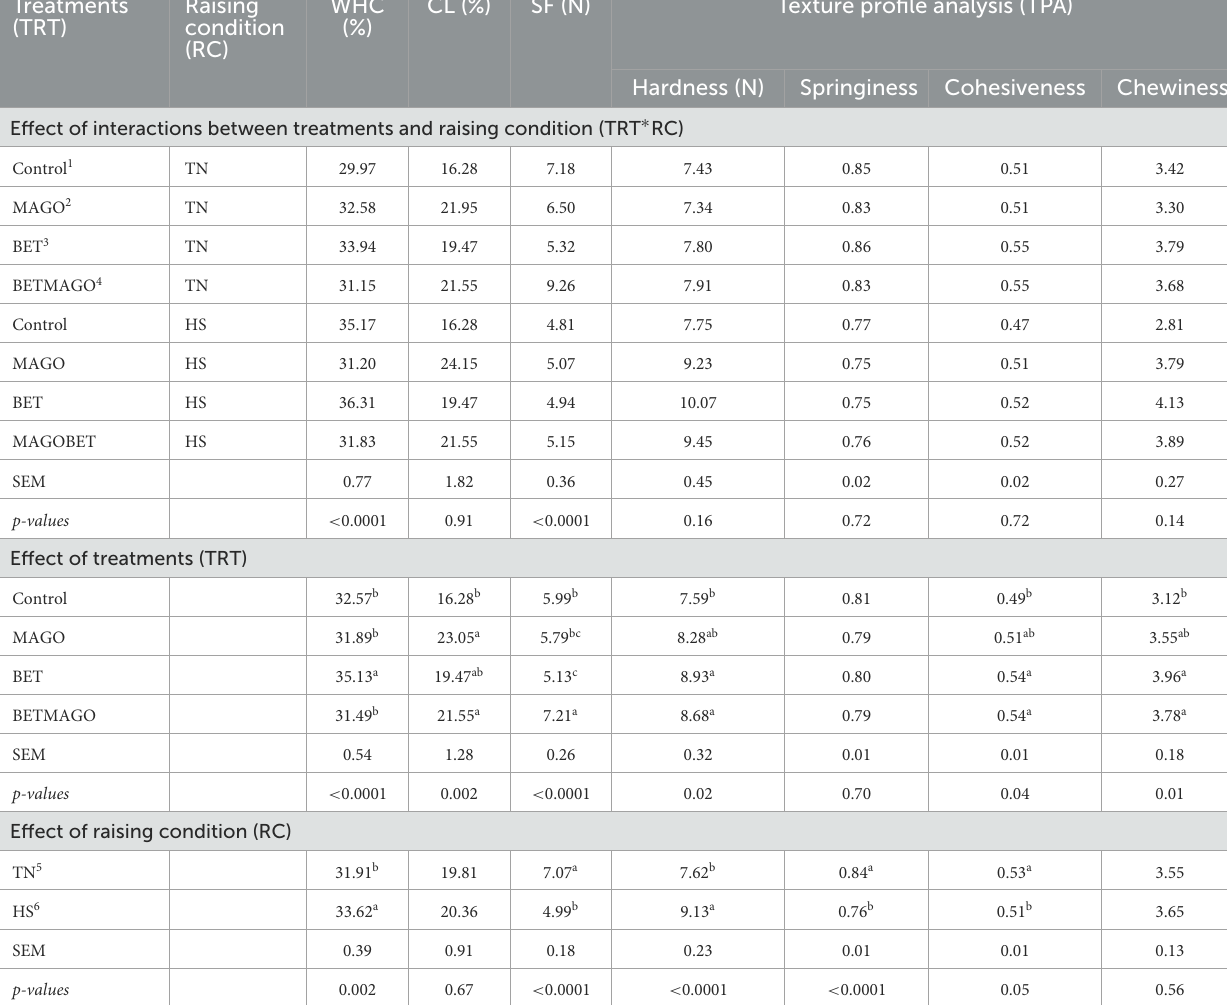
TABLE 5 Effect of the treatments on chicken breast objective eating quality measures at d 35 under thermoneutral (TN) and heat stress (HS) raising conditions. Treatments Raising (TRT) condition